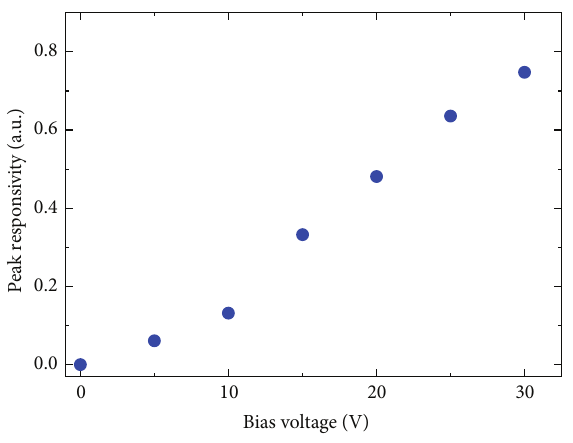
Figure 7: Peak responsivity versus bias voltage of the Mg 0.52 Zn 0.48 O